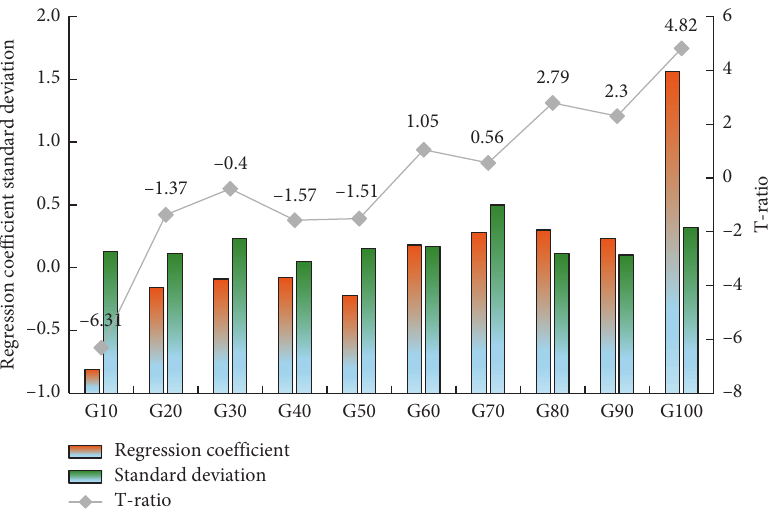
Figure 10: Results of multilevel linear regression model between subjective factors and social service